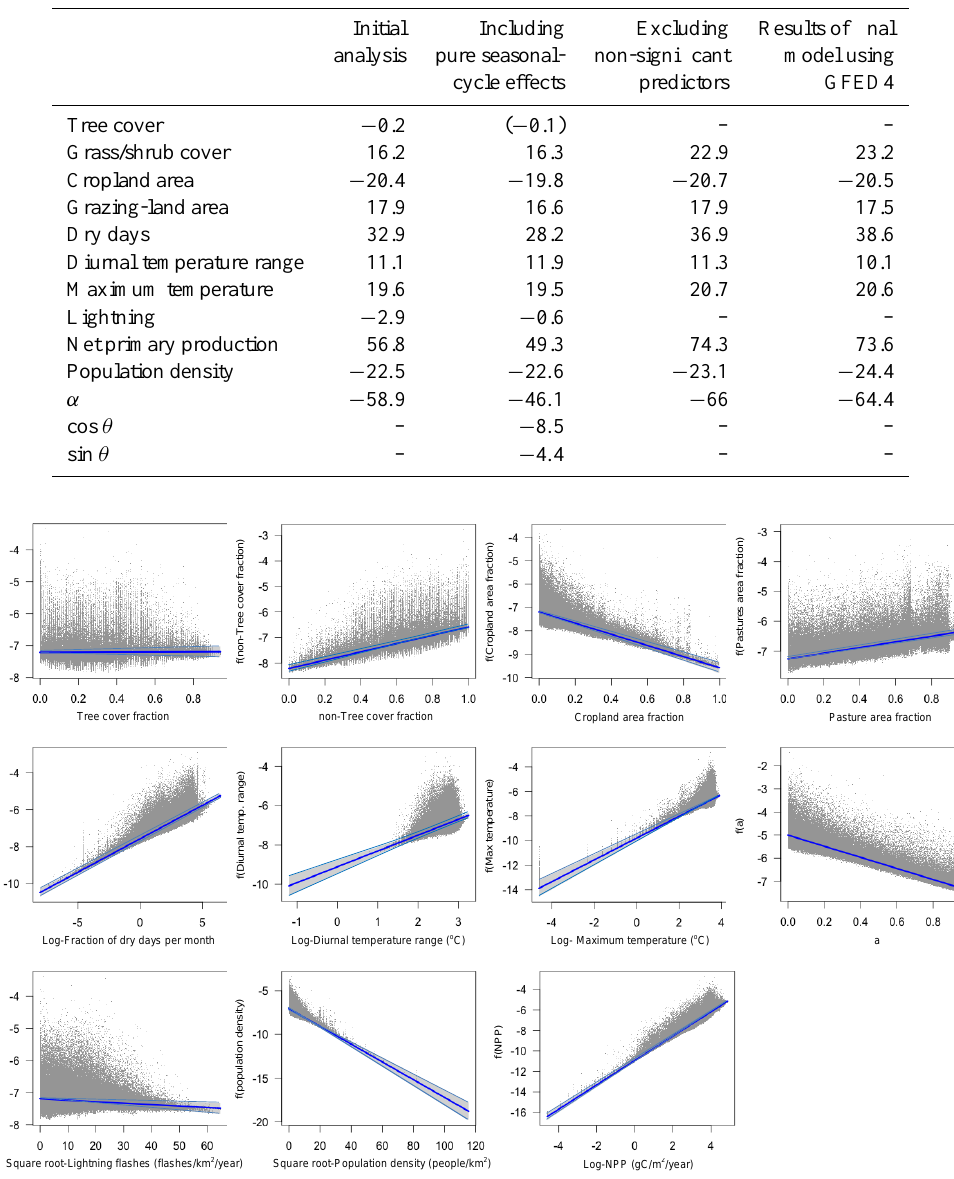
Figure 1. Partial residual plots for the main analysis (Table 2, first column), showing the relationship between the logit-transformed proba- bility of burnt area in a given month ( f ) and the predictor variables, after taking account of the fitted partial effects of all the other predictors. The blue line shows the partial fitted relationship, and the pink shaded area shows the standard errors, while the grey points show the actual values. The land-use categories are fractional coverage, whereas the number of dry days, diurnal temperature range, maximum temperature, and net primary productivity (NPP) are log transformed, and lightning and population density are square-root transformed (Table